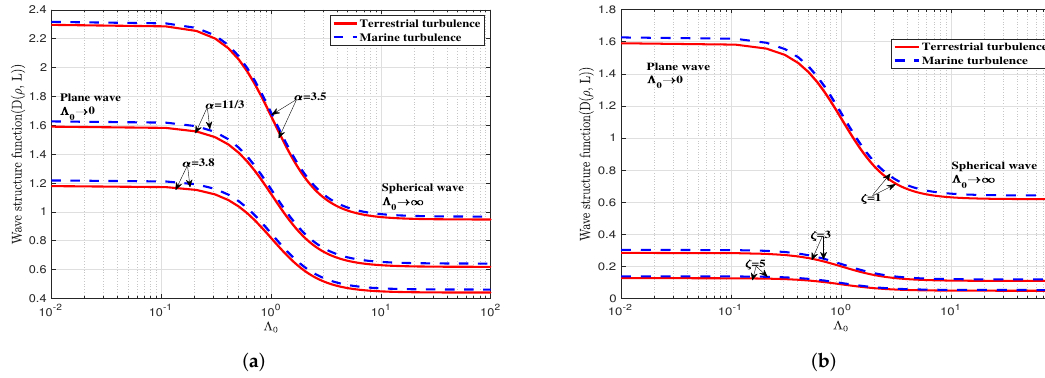
Figure 1. Wave structure function (WSF) of a collimated beam at transmitter as a function of Λ 0 for varying: ( a ) power exponent α and ( b ) anisotropic parameter ζ .